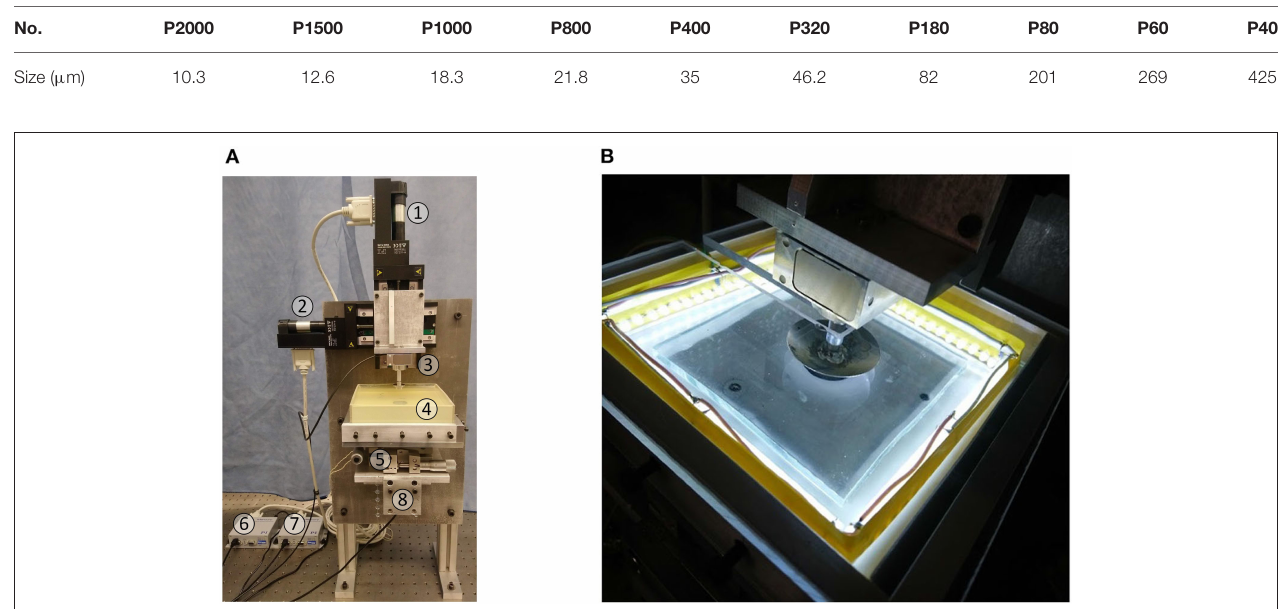
FIGURE 2 | Photograph of the experimental device: (A) entire device and (B) contact zone between steel indenter and 5-mm-thick layer of transparent rubber located on the glass plate.